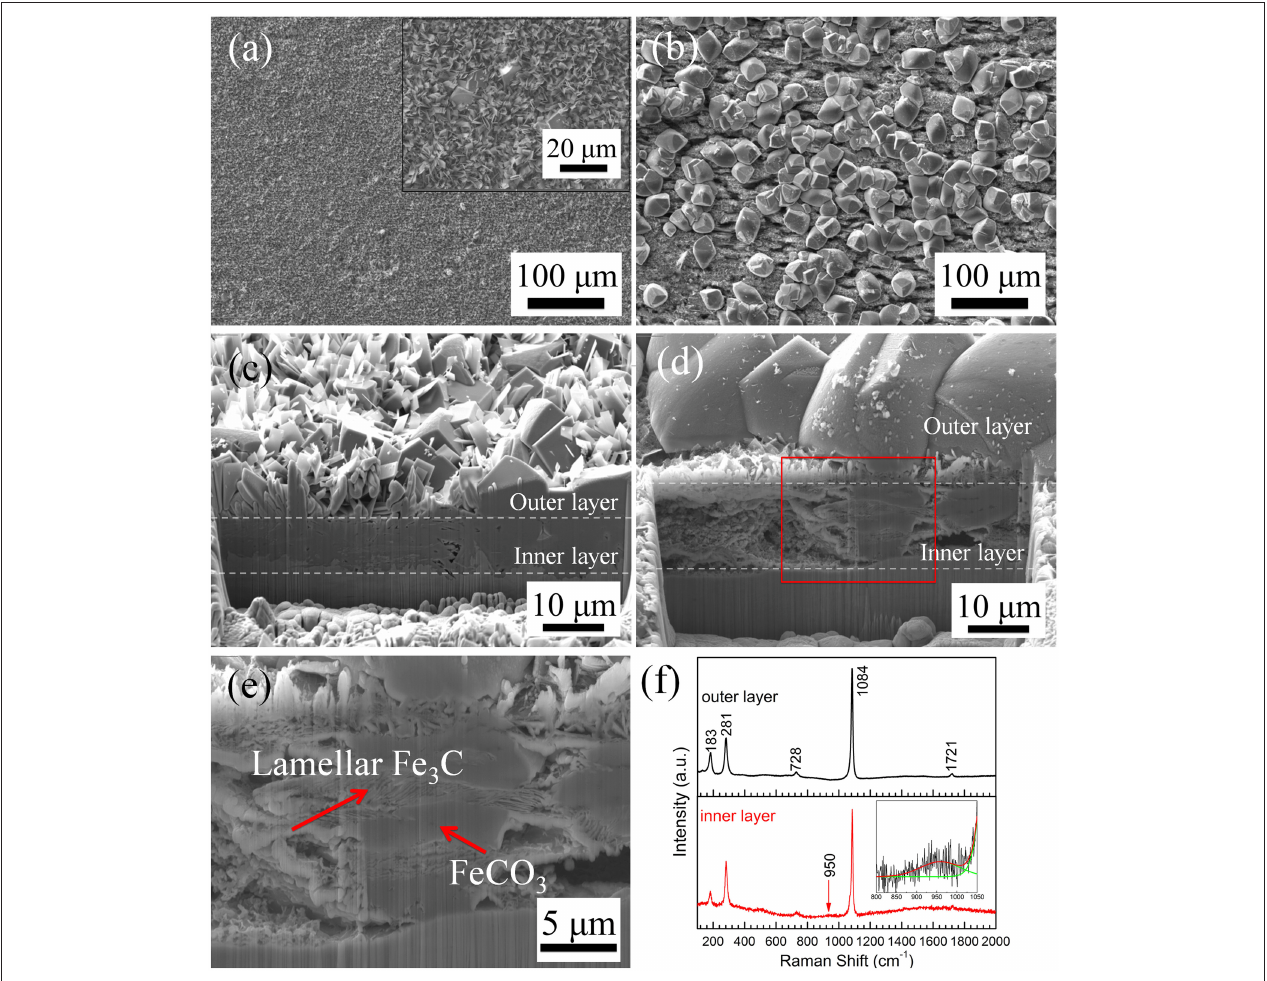
FIGURE 9 | (a) Surface and (c) cross-sectional morphologies of C1018 steel sample tested in 0.01% NaCl at 80 ◦ C; (b) surface and (d,e) cross-sectional morphology of C1018 steel sample tested in 10% NaCl solution at 80 ◦ C; (f) Raman spectra obtained from the inner and outer corrosion product